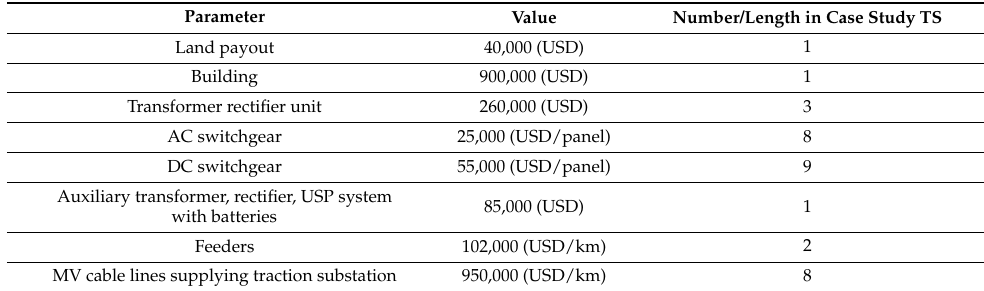
Table 4. The cost assumptions for conventional 3 kV DC traction